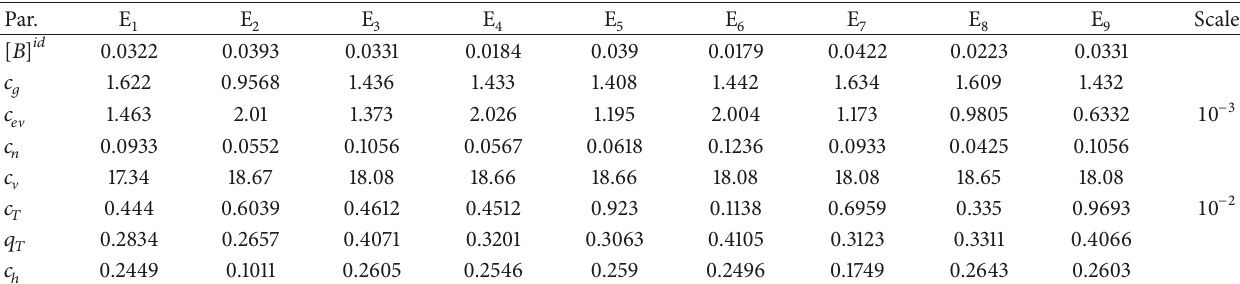
Table 9: Model parameter values resulting from fitting to individual trajectories in the case of therapy 2 (mice E 1 -E 9 ). Par.